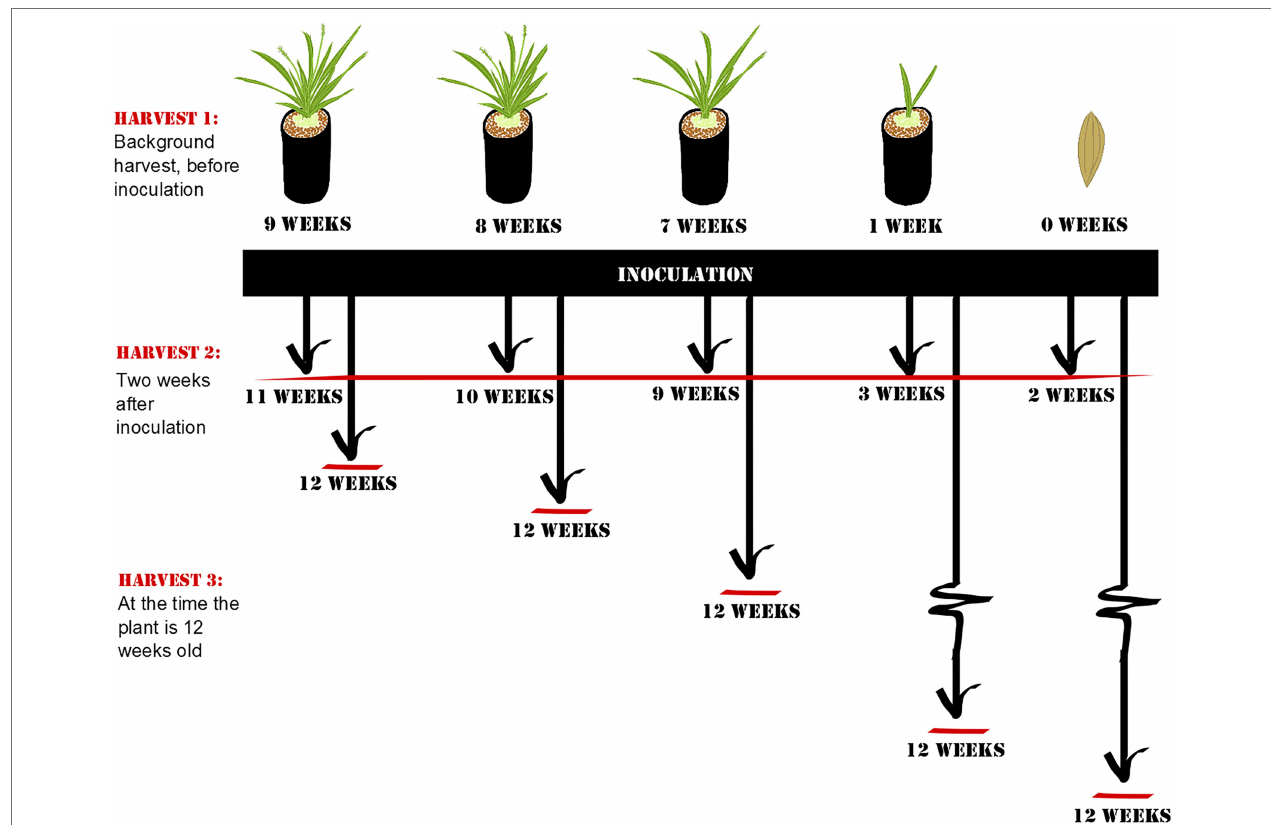
FIGURE 1 | Schematic overview of Experiment 1: Window of opportunity. At each harvest, root samples of Setaria viridis were collected. Harvest 1 controls for community composition prior to inoculation and includes plants of representing different developmental stages (flowering, budding, non-reproducing mature plant, seedling, and seed). Harvest 2 was collected 2 weeks after inoculation to control for the length of exposure to the inoculum, and Harvest 3 was collected when the plant was 12 weeks old to control for the age of the plant. The age of the plants at the time of harvest is listed in the